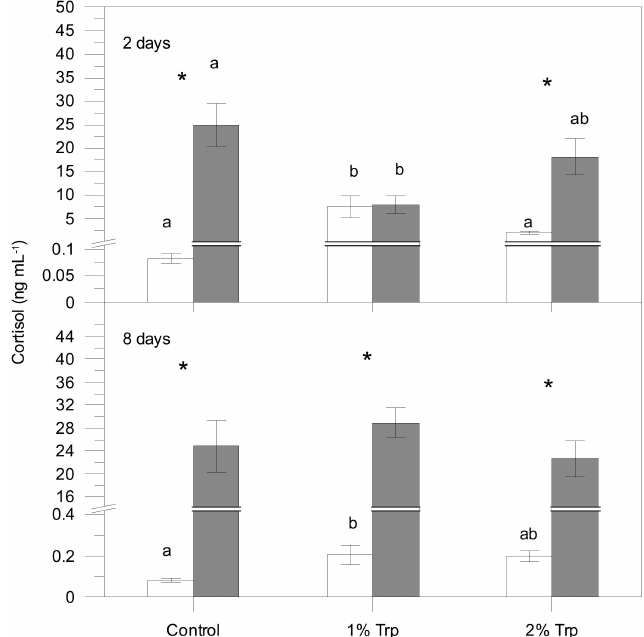
Figure 1. Plasma cortisol concentration for each treatment (mean ± SE). White and grey bars are pre- and post-stress values, respectively. Asterisks indicate significant di ff erences between pre- and post-stress conditions. Di ff erent letters indicate significant di ff erences among groups (di ff erent experimental feeds) within each sampling (pre- and post-stress).